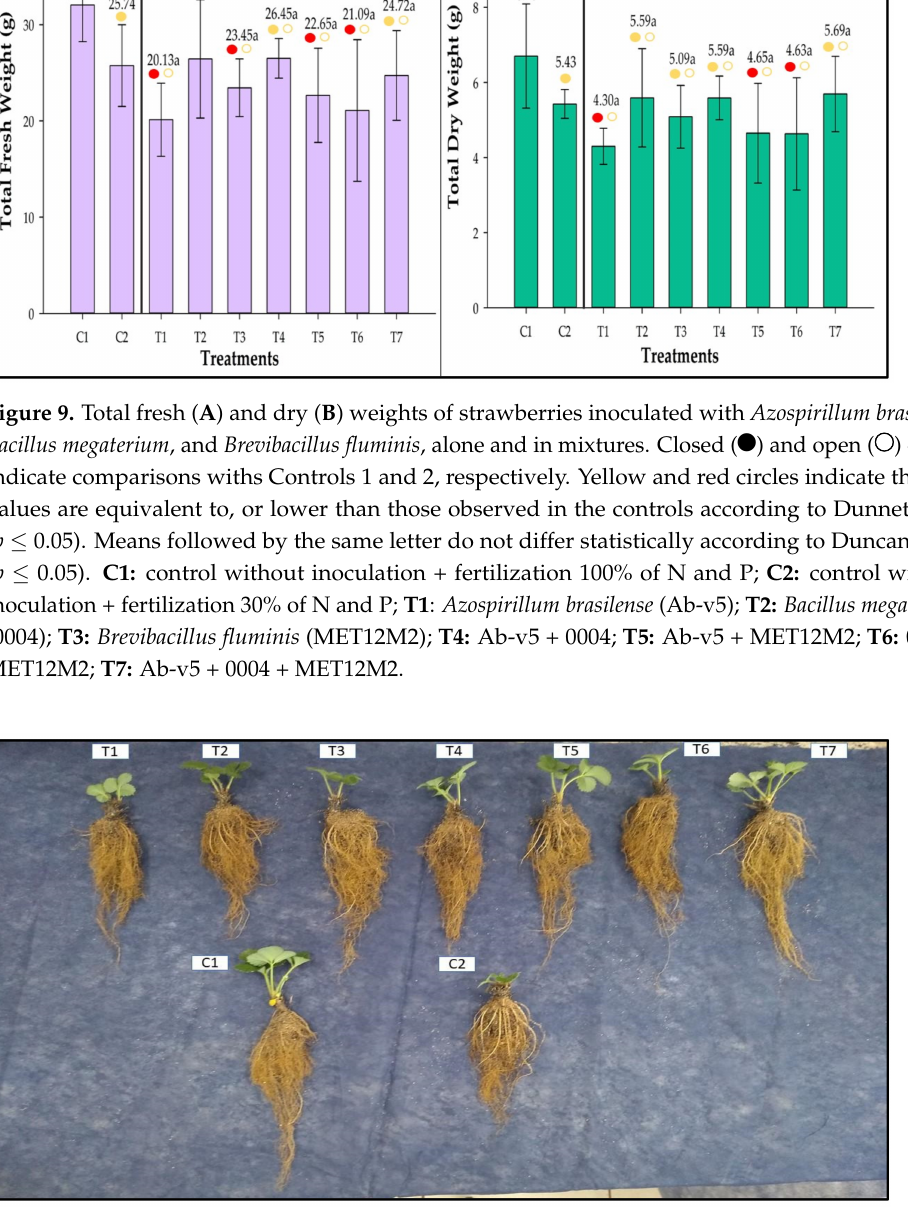
Figure 10. Roots of strawberries inoculated with Azospirillum brasilense , Bacillus megaterium , and Brevibacillus fluminis , alone and in mixtures. C1: control without inoculation + fertilization 100% of N and P; C2: control without inoculation + fertilization 30% of N and P; T1 : Azospirillum brasilense (Ab-v5); T2: Bacillus megaterium (0004); T3: Brevibacillus fluminis (MET12M2); T4: Ab-v5 + 0004; T5: Ab-v5 + MET12M2; T6: 0004 + MET12M2; T7: Ab-v5 + 0004 +